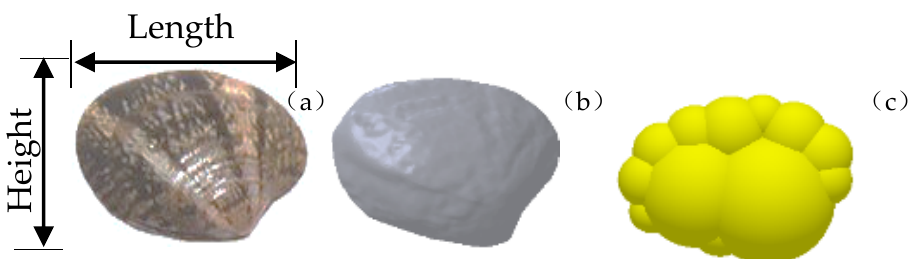
Figure 1. Clam ( a ), Clam 3D shape ( b ), and Clam DEM shape ( c ).